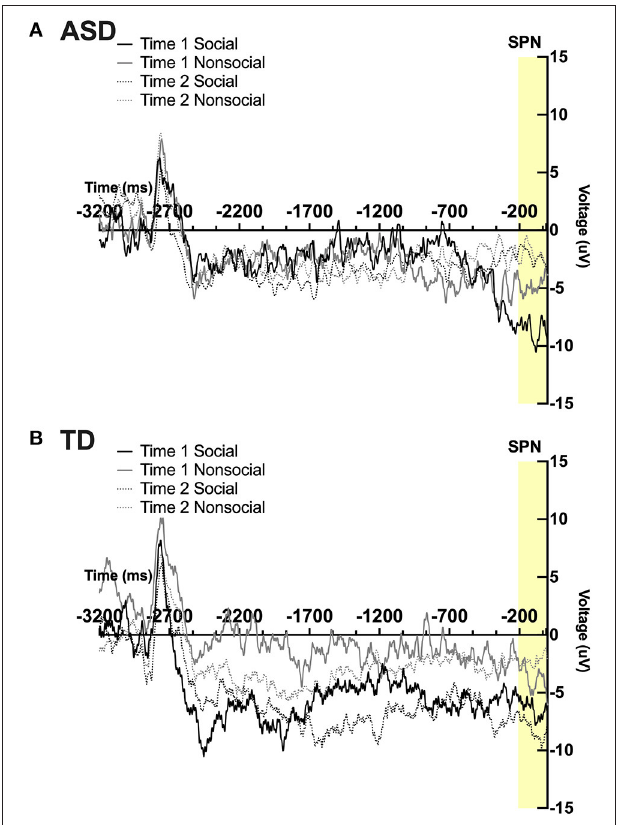
FIGURE 3 | Grand average waveforms in the social and non-social conditions at Time 1 and Time 2 from the Stimulus Preceding Negativity (SPN) in (A) ASD participants and (B) TD participants.